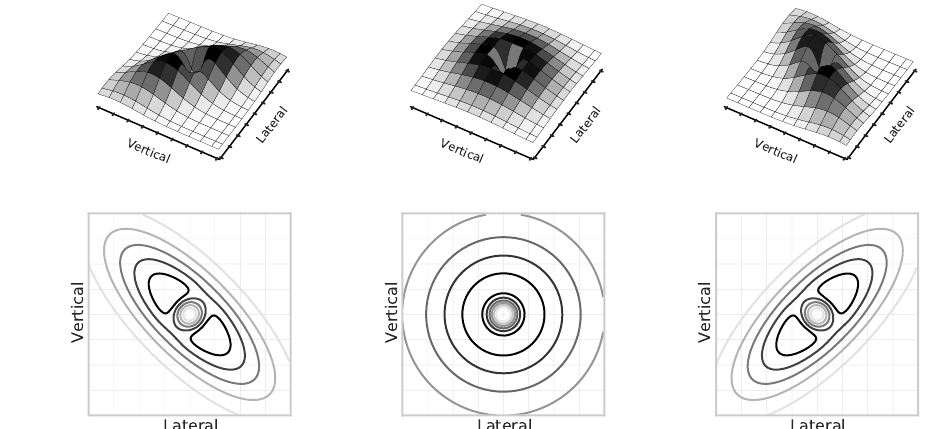
, σ y , σ z , σ z , A 1 , and A 2 , but varying correlation 1 2 1 2